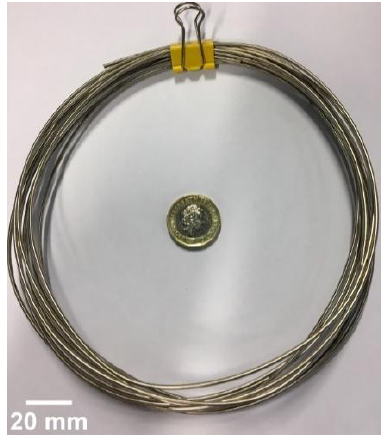
Figure 14. Photograph of a 5 m 1.27 mm ID Pt/SiO 2 coated tube reactor along with a pound coin for scale.